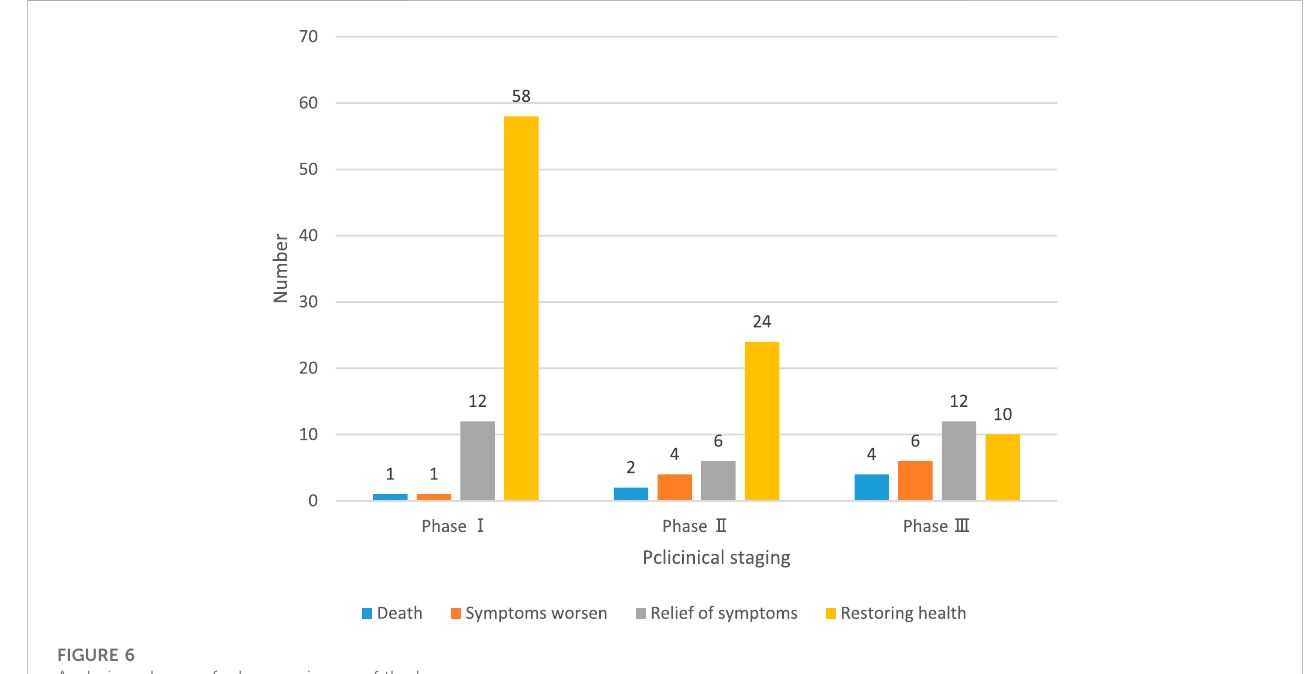
FIGURE 6 Analysis and cure of adenocarcinoma of the